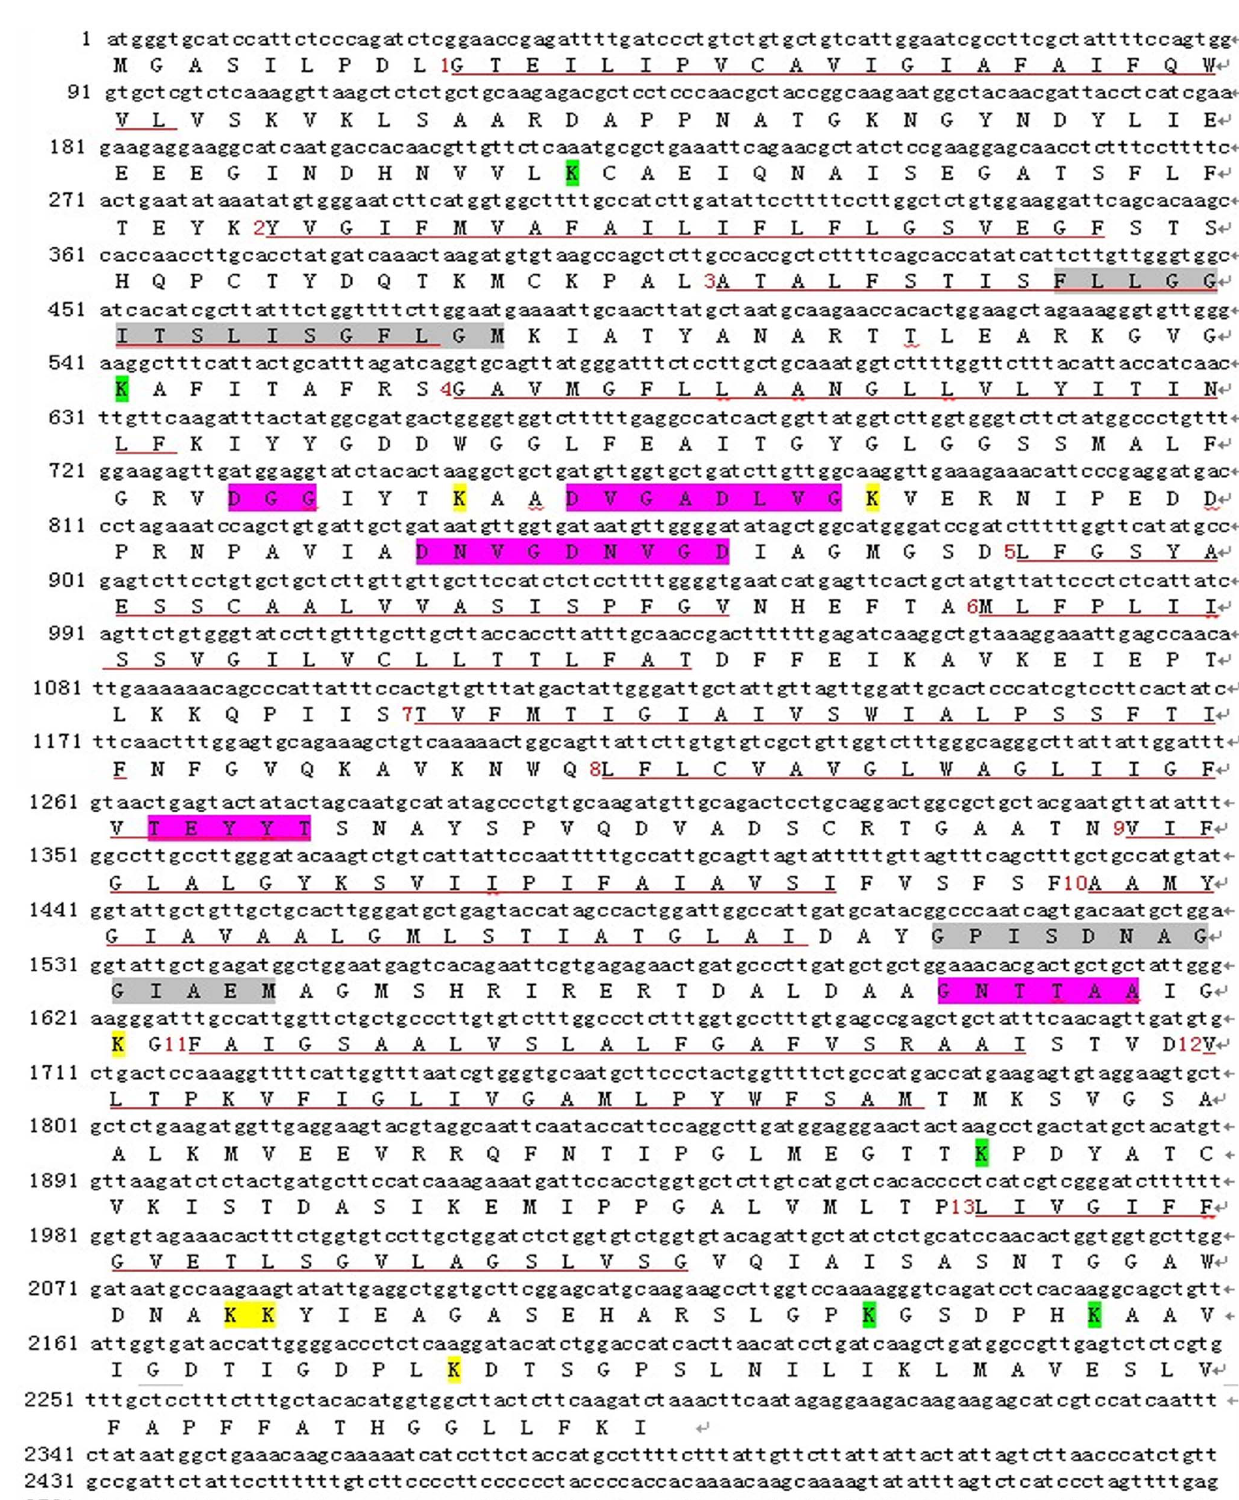
Figure 2. The sequence and transmembrane prediction of SaVP1 . There are 13 transmembrane regions in SaVP1 which are marked with red Arabic numerals. The yellow marked K is group I, and the green marked K is group II. The purple marked segment consists of identified conserved domains. The grey marked segment consists of supposed novel conserved motifs.